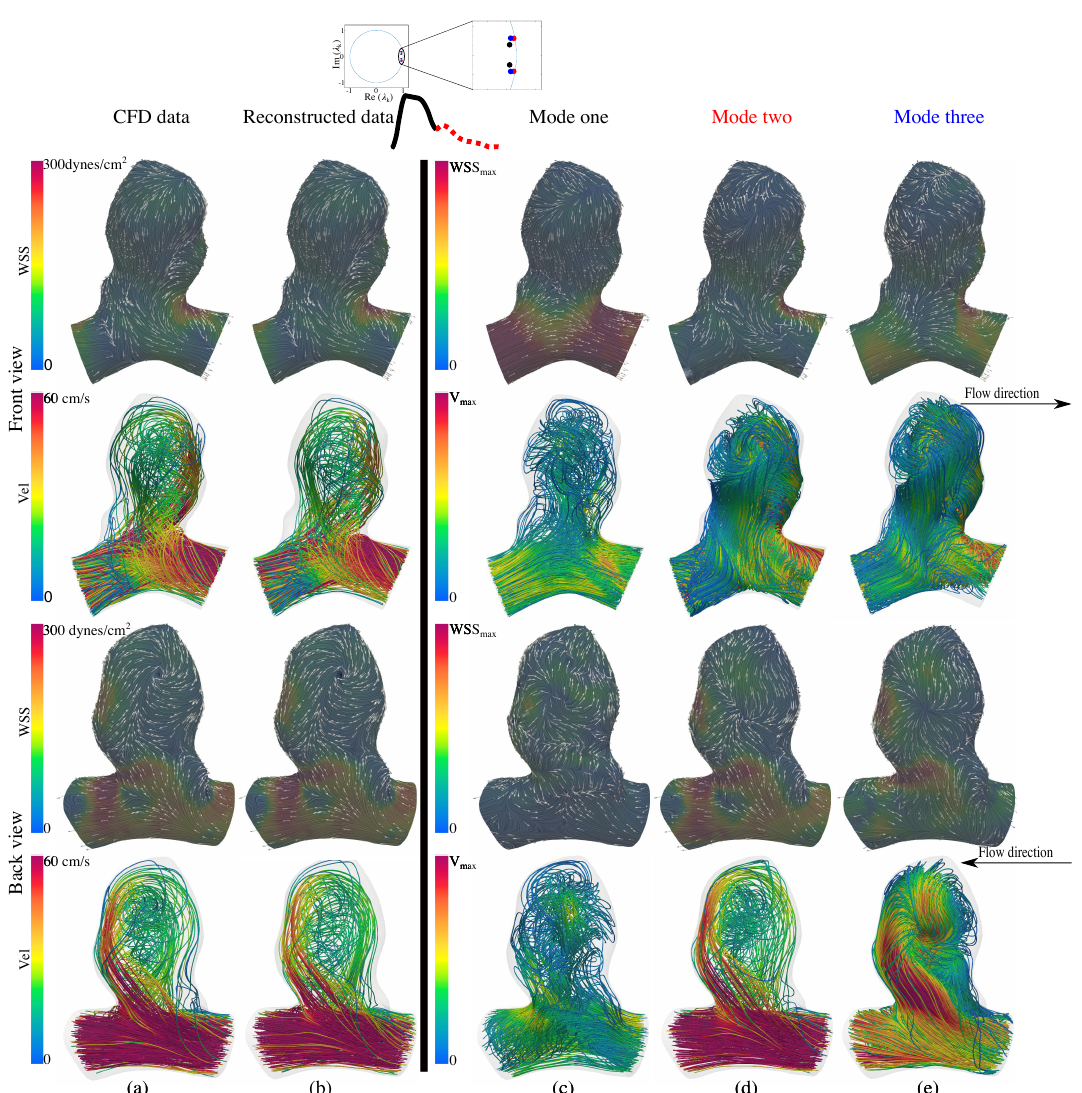
Figure 10. Velocity and WSS CFD data and the mDMDc modes are shown in the sixth stage of the cerebral aneurysm model. The stage is highlighted with a red dashed line in the flow waveform. The location of discrete eigenvalues in the unit circle corresponding to the selected mDMDc modes are shown. Velocity and WSS streamlines are shown and colored by their magnitude. WSS vectors are normalized and shown on top of the WSS streamlines to show the WSS vector direction. ( a ) CFD data (time = 0.47 s), ( b ) reconstructed data with 95% accuracy, ( c ) real part of the mDMDc mode corresponding to the eigenvalue λ = 0.93 ± 0.10 i , ( d ) real part of the mDMDc mode corresponding to the eigenvalue λ = 0.97 ± 0.17 i , ( e ) real part of the mDMDc mode corresponding to the eigenvalue λ = 0.94 ± 0.17 i